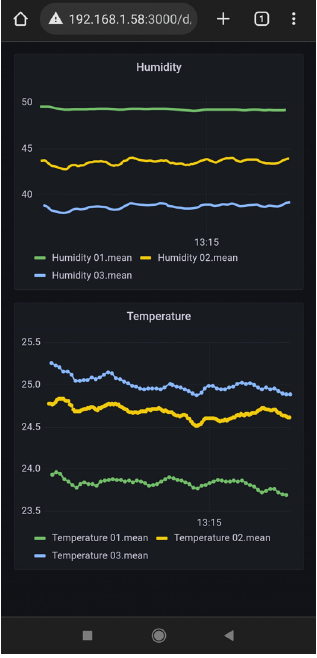
Figure 10. Mobile Grafana, own study A. Wycisk.